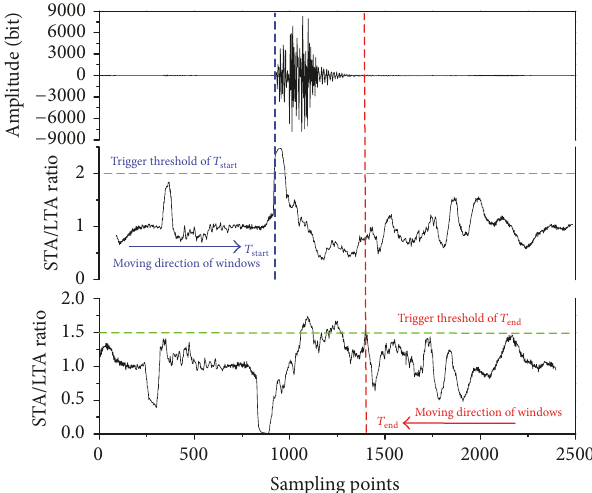
Figure 3: Diagram illustrating the arrival and termination times of a coal mining MS signal.